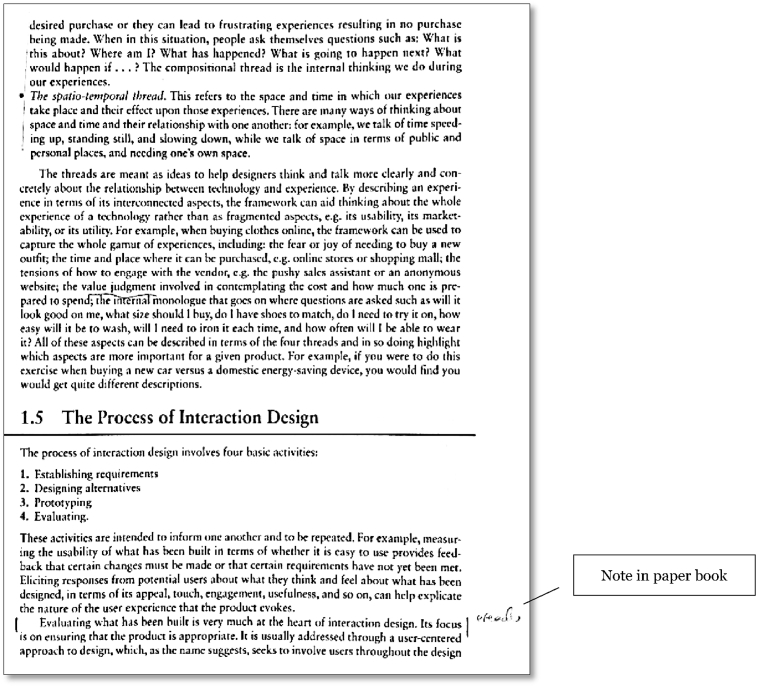
Annotations in paper book (Preece et al., 2015).